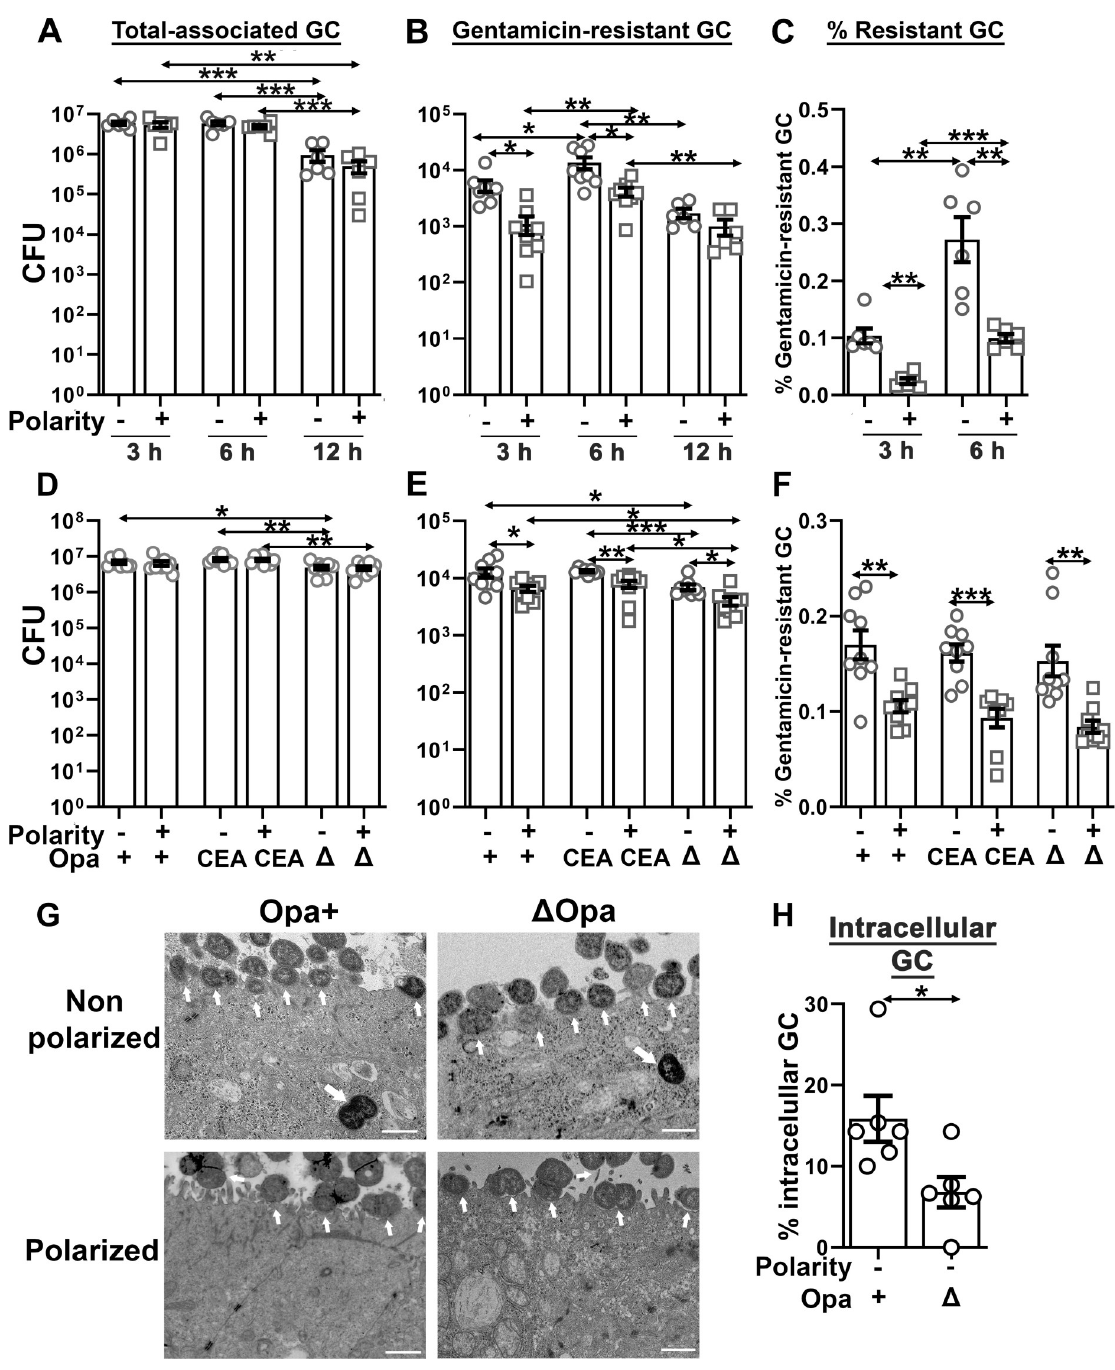
Fig 1. The polarity of epithelial cells and Opa expression regulate GC infection. (A-C) Non-polarized and polarized T84 cells were inoculated with Pil+Opa+ GC (MOI~10) from the top chamber for 3, 6, and 12 h. Infected epithelial cells were lysed before and after gentamicin treatment to determine total epithelial-associated GC ( ± SEM) (A) and gentamicin-resistant GC ( ± SEM) (B) . The percentage of gentamicin-resistant GC among total epithelial-associated GC were calculate (C) . (D-F) Cells were inoculated with Pil+Opa+, Opa CEA, or Δ Opa GC (MOI~10) from the top chamber for 6 h. Total epithelial-associated GC ( ± SEM) (D) , gentamicin-resistant GC ( ± SEM) ( E) , and the percentage of gentamicin-resistant GC among total epithelial-associated GC were quantified (F) . Data points represent individual transwells (A-F) . (G, H) Cells were incubated with Pil+Opa+ or Pil+ Δ Opa GC (MOI~50) from the top chamber for 6 h, fixed, and processed for transmission electron microscopy (TEM). Representative images of GC-inoculated non-polarized and polarized T84 cells are shown (G). Small arrows, GC directly contacting epithelial membranes; and big arrow, intracellular GC. The level of GC invasion in non-